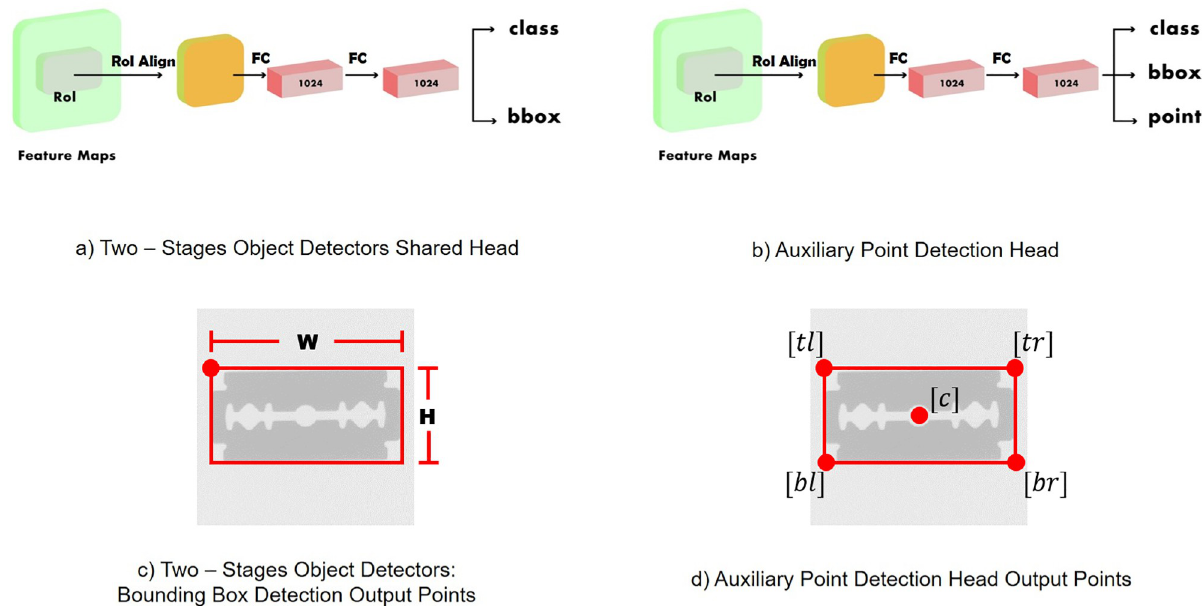
Fig 5. Architectural and bounding box detection-output comparison between the two-stage object detector shared head and proposed auxiliary point detection head: a) two-stage object detector shared head architecture, b) proposed auxiliary point detection architecture, c) two-stage object detectors: bounding box detection-output points, and d) auxiliary point detection head output